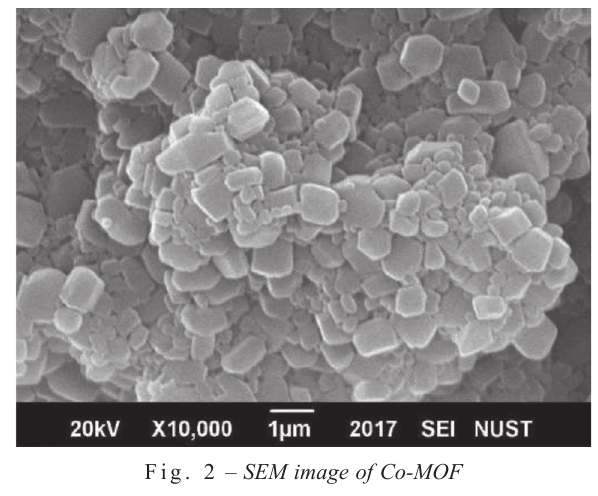
Fig. 2 – SEM image of Co-MOF